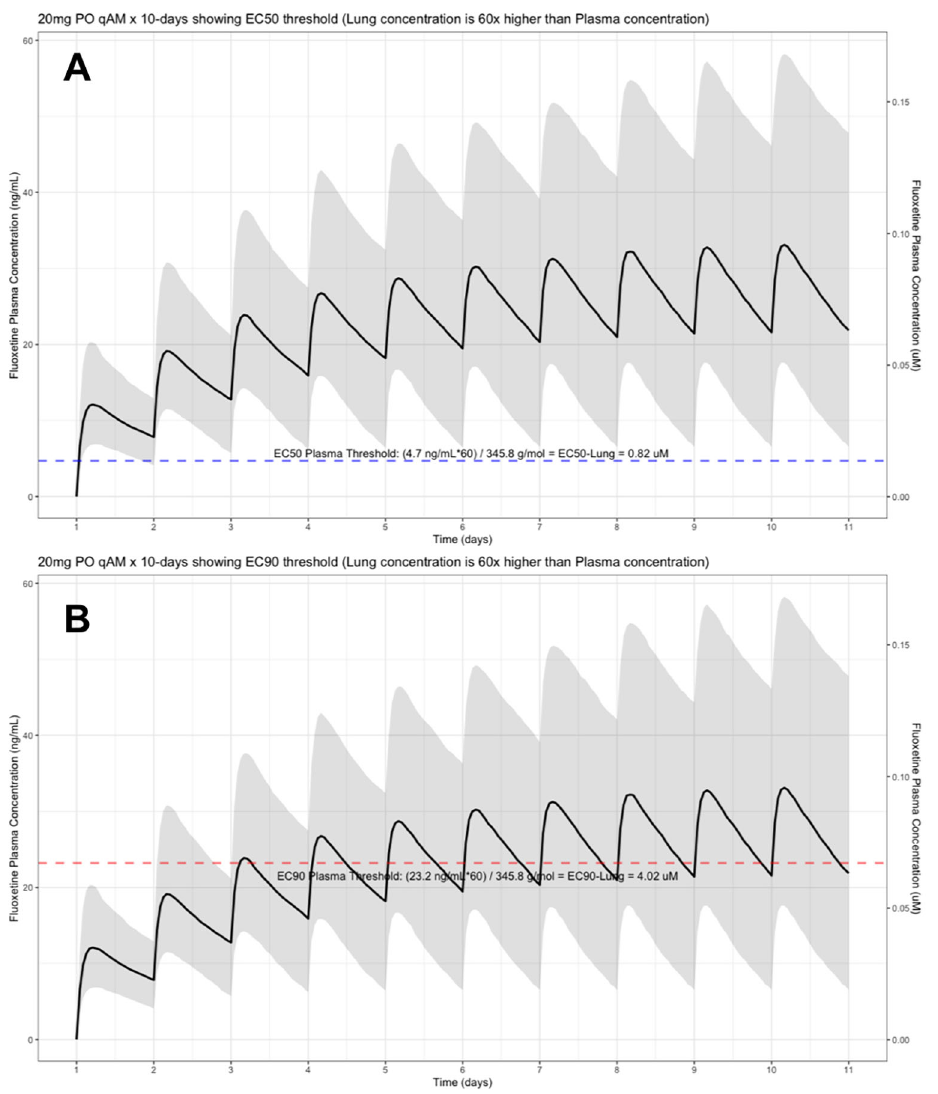
Figure 1. Fluoxetine population (n=1,000) dosing simulation results for an oral dose of 20 mg/day for 10 days. The shaded regions illustrate the 10th (lower) and 90th (upper) percentiles with the solid line within the shaded region representing the median fluoxetine concentration. The dashed horizontal line depicts the effective concen- tration resulting (A) 50% and (B) 90% inhibition (EC90) of SARS-Cov-2 that will result in 60-times higher level in the